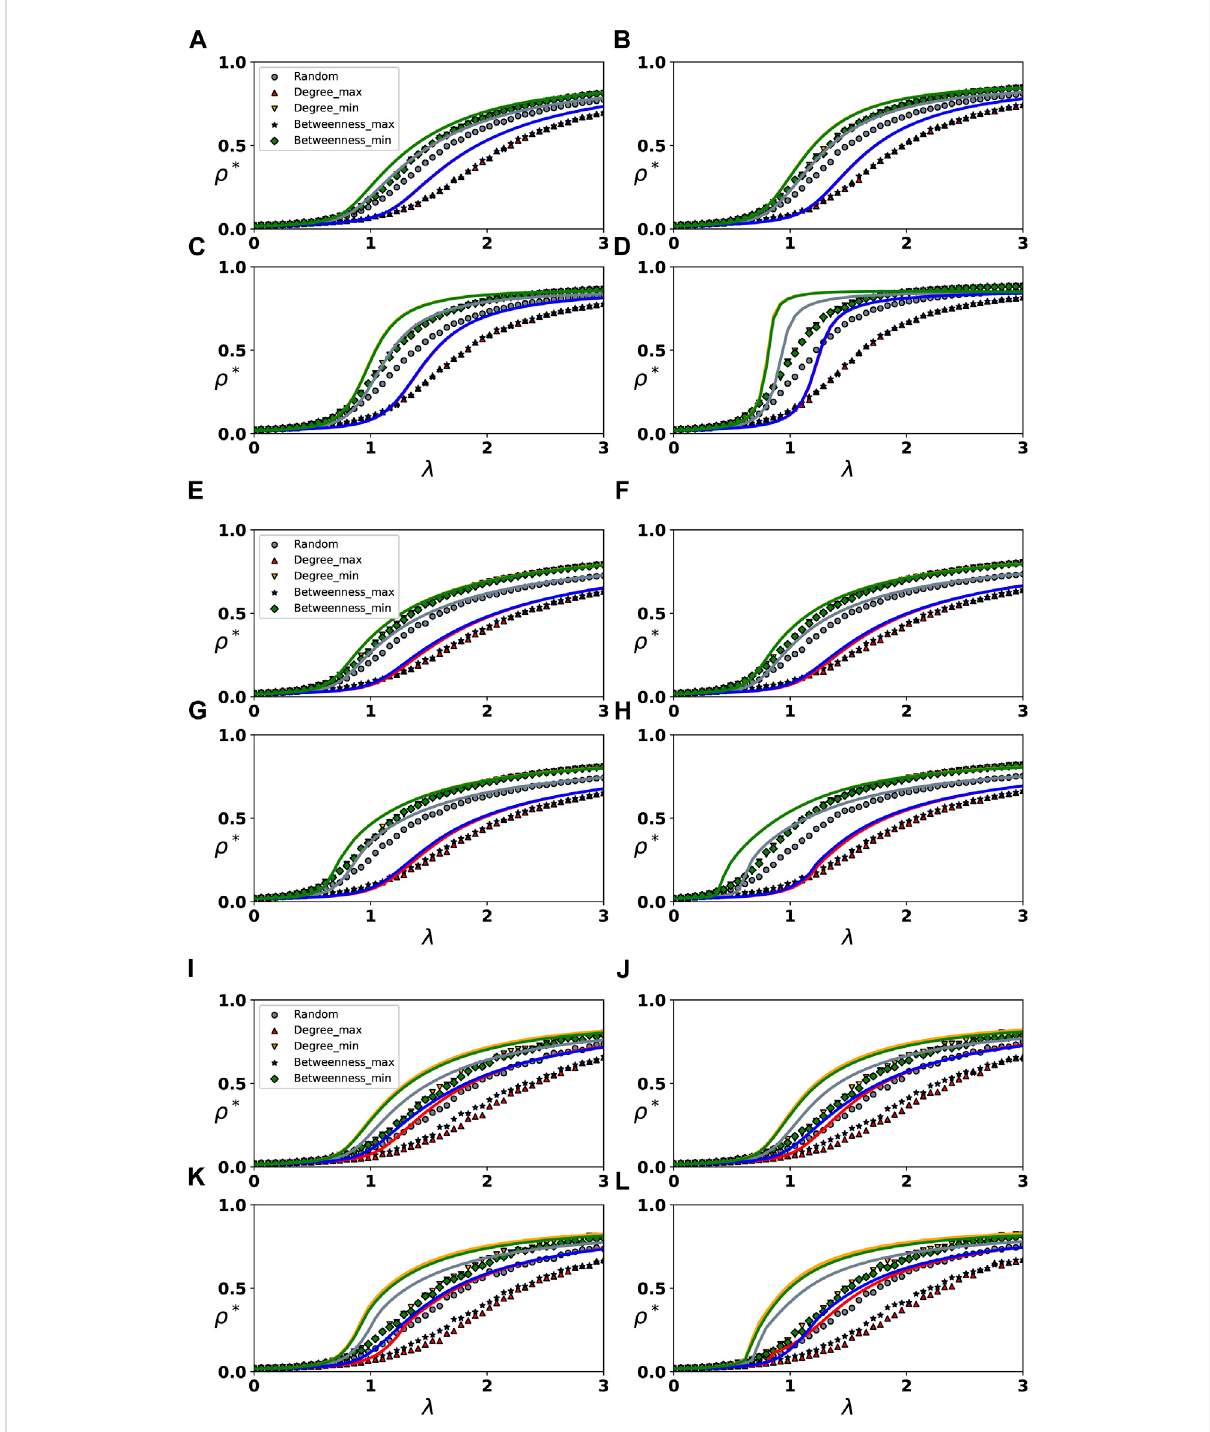
FIGURE 3 Evolution of the fi nal infection density ρ * with λ under varying 2-complex infection rates and immunization strategies. Subgraphs (A – D) , (E – H) and (I – L) represent the spread of epidemics on the synthetic network and two real-world networks, respectively. Different colors and symbols have been used to depict different immunizationstrategies.For the spread on the heterogeneous network, we set λ * = 0.5 in (A) , λ * = 3.5 in (B) , λ * = 6.5 in (C) and λ *=12in (D) .Forthespreadonthereal-worldnetworks,weset λ *=0.5in (E) and (I) , λ *=1.5in (F) and (J) , λ *=2.5in (G) and (K) , λ *=4.5 in (H) and (L)